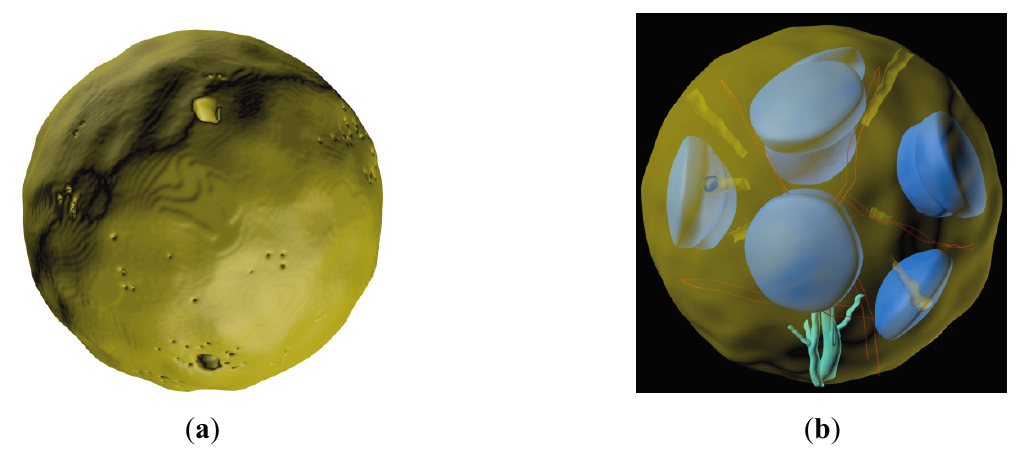
Figure 5. ( a ) Subcapsular sinus and ( b ) the composed LN without